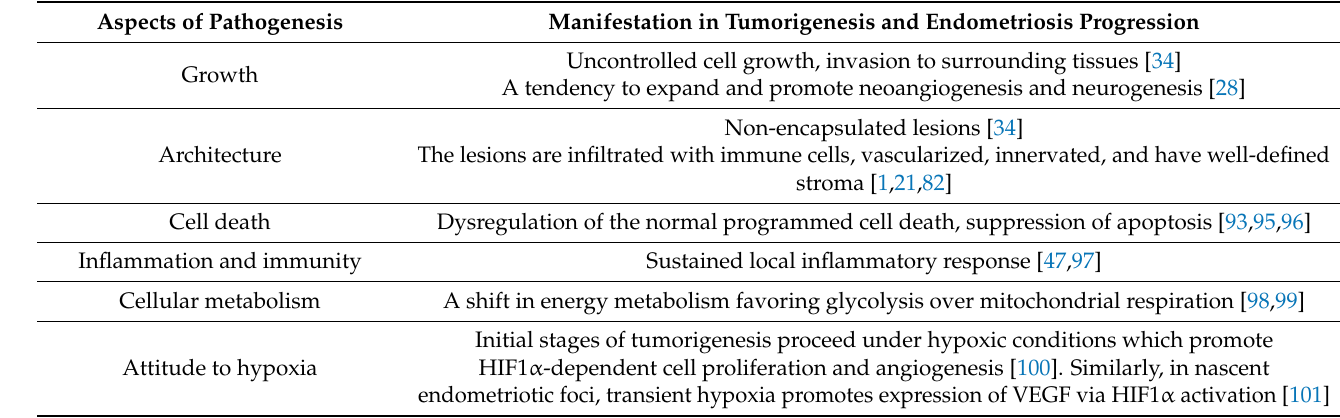
Table 2. Summary table showing the generic similarity between endometriosis progression and tumor growth with specification of the roles of